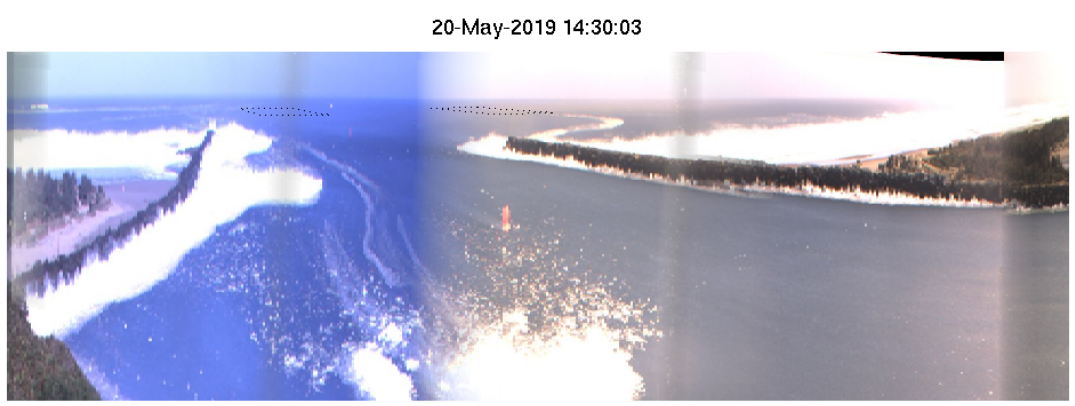
Figure 6. Example of pan “brightest” image of the seaward region of interest (ROI) for Coos Bay for 20 May 2019, 1430 GMT. The wave height was 2.35 m, period was 11.0 s, tide level was − 1.63 m and the wave direction was 252 ◦ . The Site E and Site F dredge disposal sites are marked offshore of the inlet with lightly dotted lines. A red channel marker is visible near the inlet center. The white region at the bottom of the image corresponds to wave breaking over Guano Rock, a submerged feature (the main channel lies to the right of this location).